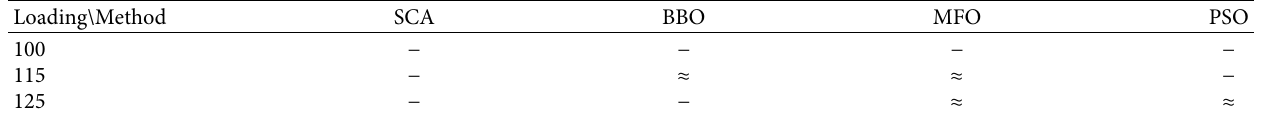
Table 9: WSRT results on IEEE 118 bus system.